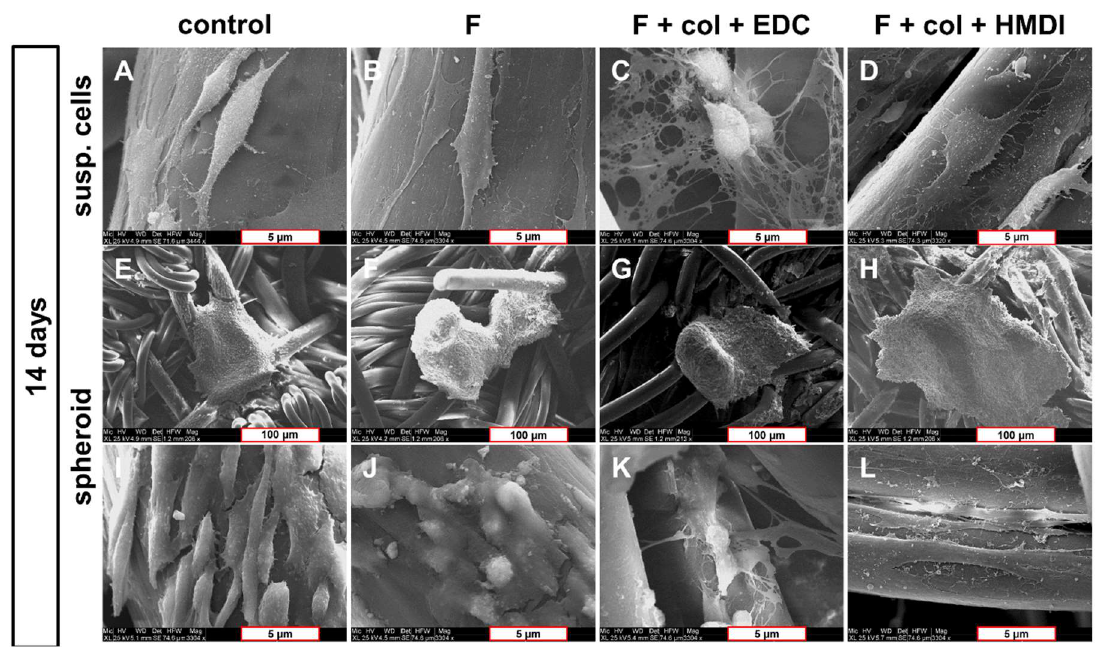
Figure 4. Cell morphology of the LACL-derived fibroblasts on embroidered scaffold functionalization variants using SEM after 14 days in culture. Scaffolds were either dynamically seeded with suspended cells (susp. cells, A – D ) or statically with spheroids ( E – L ). Differences in cell shape and distribution can be seen in the dynamical ( A – D ) as well as in the statical culture ( E – L ) on the non-functionalized scaffold ( A , E , I ), the one with only the fluorination ( B , F , J ), the fluorinated scaffolds with EDC ( C , G , K ) and the HMDI cross-linked collagen foam ( D , H , L ). A – D and I − L : scale bars of 5 µm and E – H : scale bars of 100 µm. Col, collagen foam; F, fluorinated; EDC, ethylcarbodiimide cross-linked; HMDI, hexamethylene diisocyanate cross-linked.